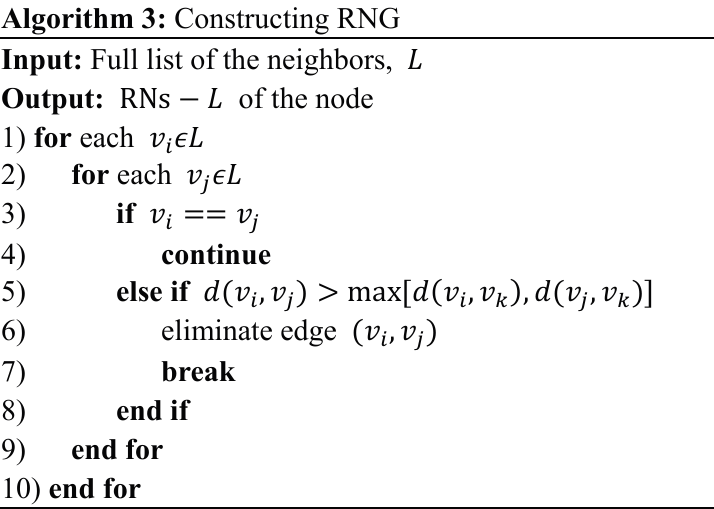
Algorithm 3: Constructing